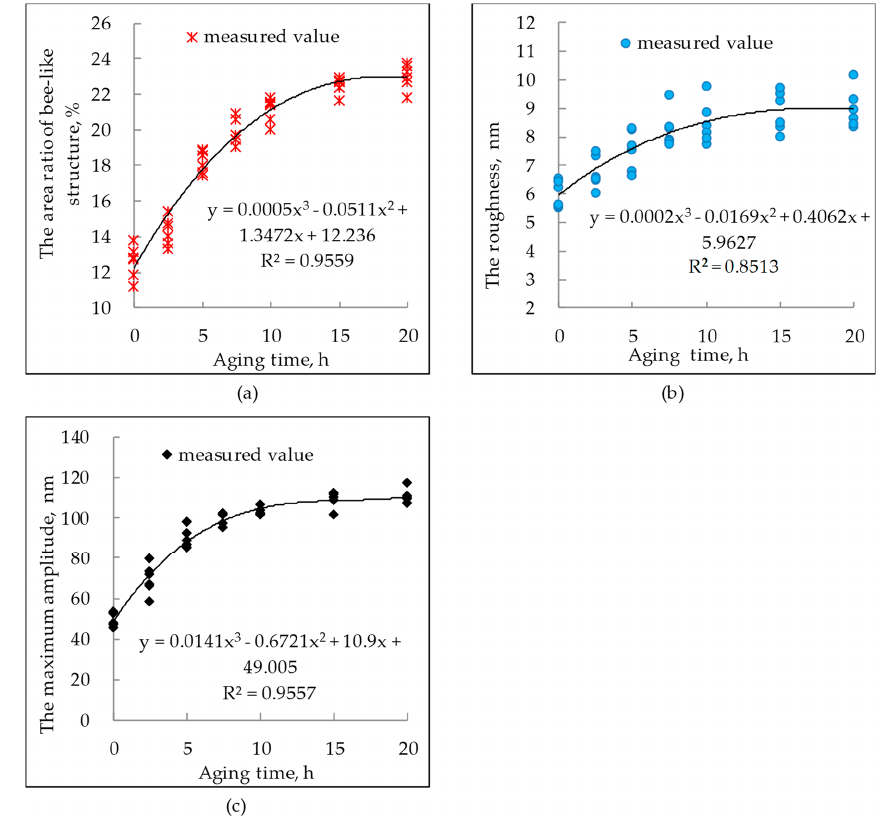
Figure 10. The relationship between nano-morphological parameters and ageing time. ( a ) the area ratio of bee-like structure; ( b ) the roughness; ( c ) the maximum amplitude. ratio of bee-like structure; ( b ) the roughness; ( c ) the maximum